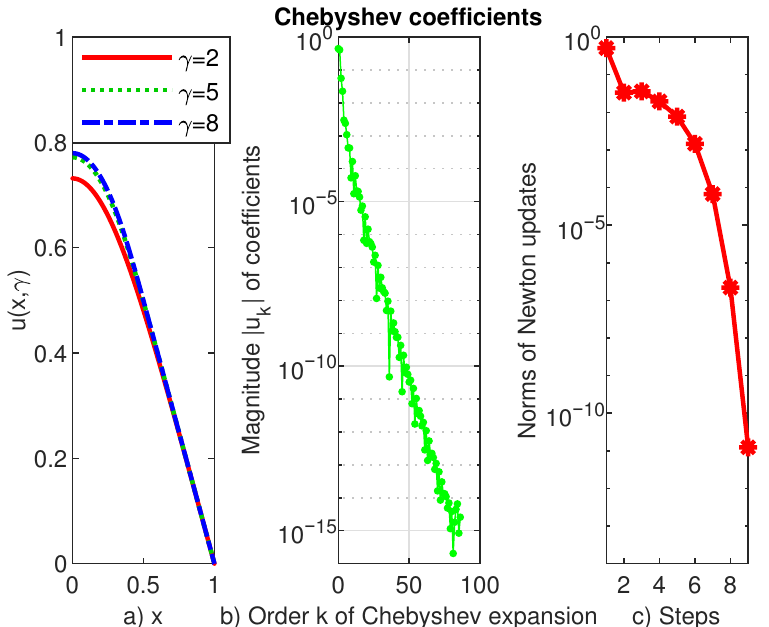
Figure 9. ( a ) Three solutions u ( x , γ ) to the problem (16) when α : = 1. ( b ) This panel shows that when γ : = 8 the Chebyshev coefficients of solution decrease almost linearly close to the machine precision with a slope a little bit larger than − 1. ( c ) Newton updates are illustrated for the same value of γ . For higher values of α than 1, Chebfun could not solve the problem even though the tolerance was considerably lower. This is not the case for the exponent γ